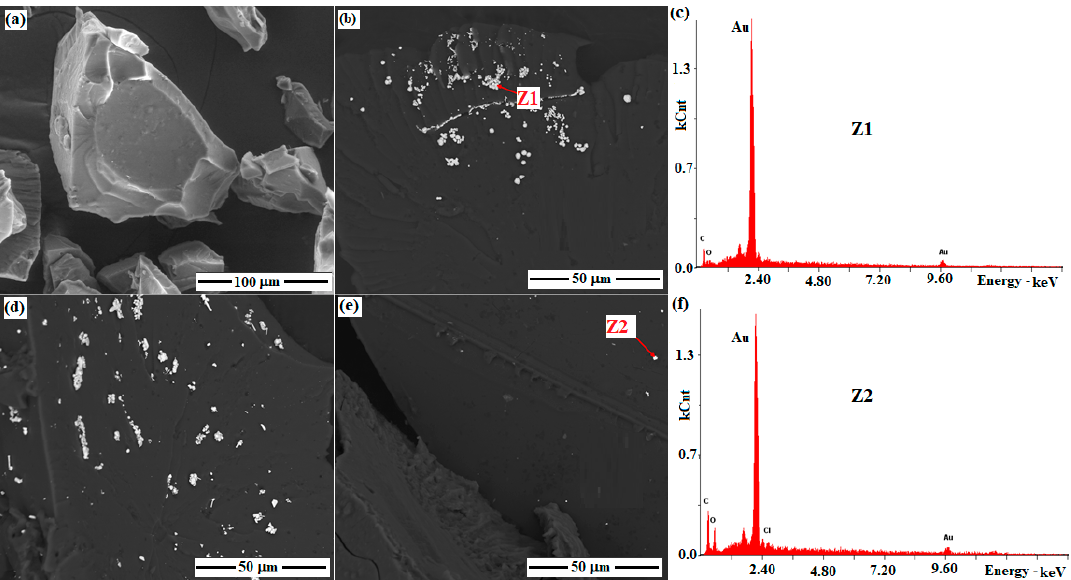
Figure 5. SEM images obtained for the pine bark tannin resin ( a ) before contact with gold, and after adsorption of gold ( b ) from 1.0 mol L − 1 HCl, and from aqua regia solutions ( d ) 1.0 mol L − 1 H + and ( e ) 2.0 mol L − 1 H + . EDS spectra obtained in the areas denoted as ( c ) Z1 and ( f ) Z2.